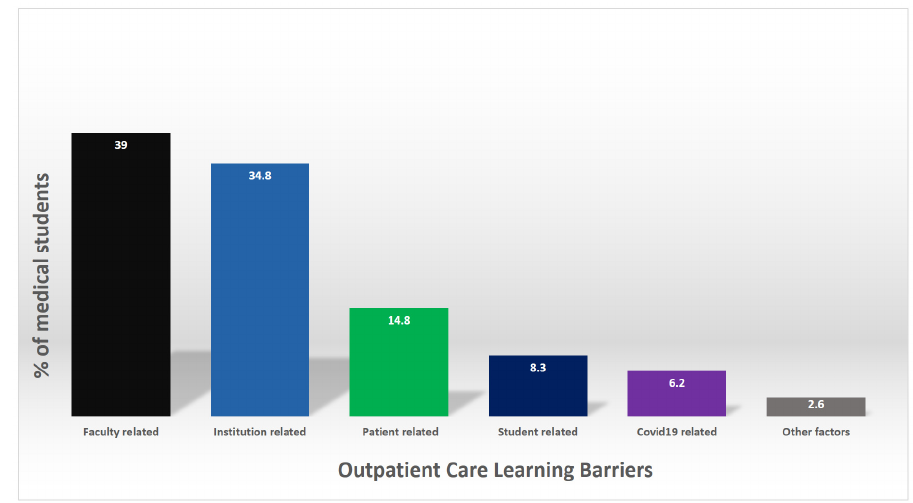
Figure 2. Medical students perceived barriers to ACC learning. Table 6. Descriptive analysis of the general perceptions of faculty towards the barriers in medical students